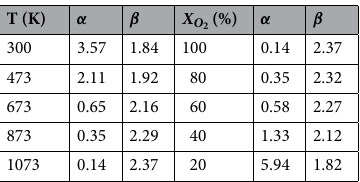
O 2 , (b) varying X O 2 at 1073 K.